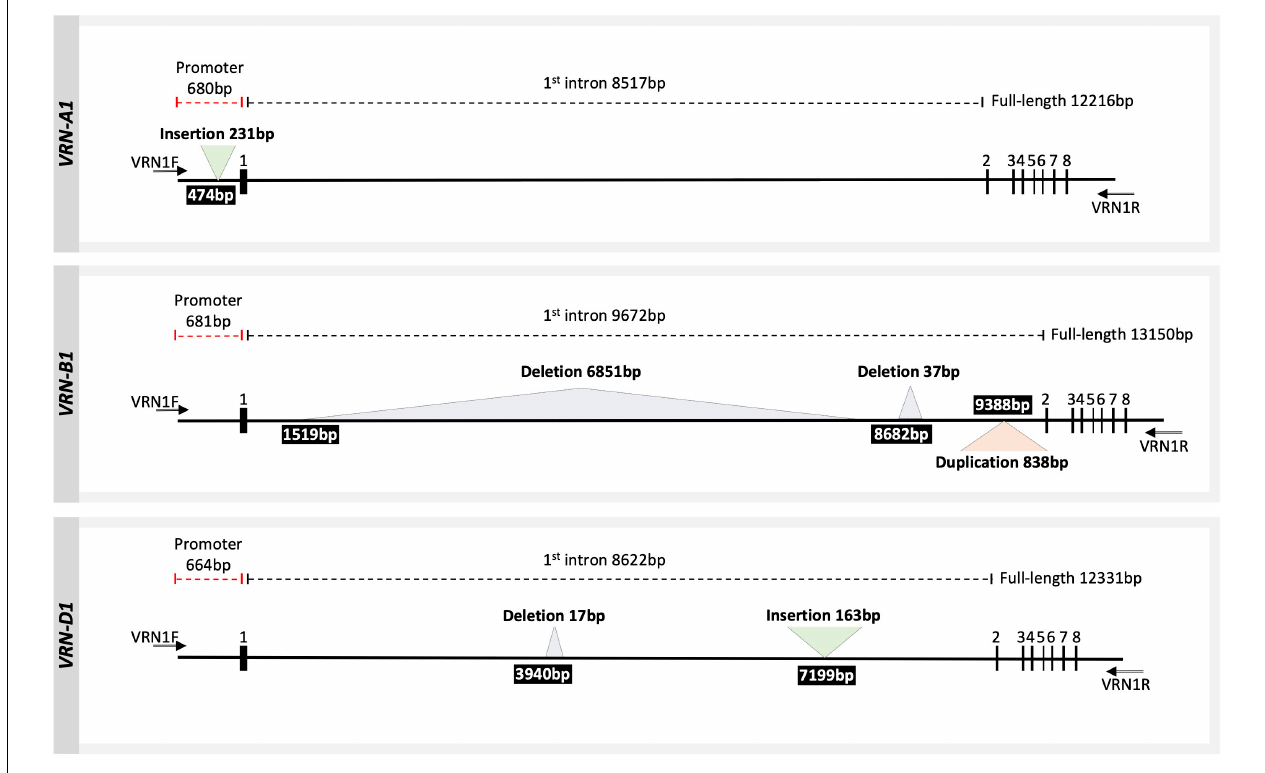
FIGURE 2 | Scheme of three homoeologous wheat VRN1 genes including complete intron–exon regions and partial promoter region. Exons are represented by numbers above bold boxes. The numbers above the dashed line represent the region length according to the Weebill, Robigus, and Claire reference sequences for VRN-A1 , VRN-B1, and VRN-D1 , respectively. The triangles represent the SVs detected in this study. The number within the black box indicates the start position of structural variation SV in a sequence (counting from the 3 (cid:48) end of the forward primer VRN1F). The two arrows indicate the positions of primers used to amplify the full-length sequence of the three homoeologous VRN1 genes (VRN1F and VRN1R).